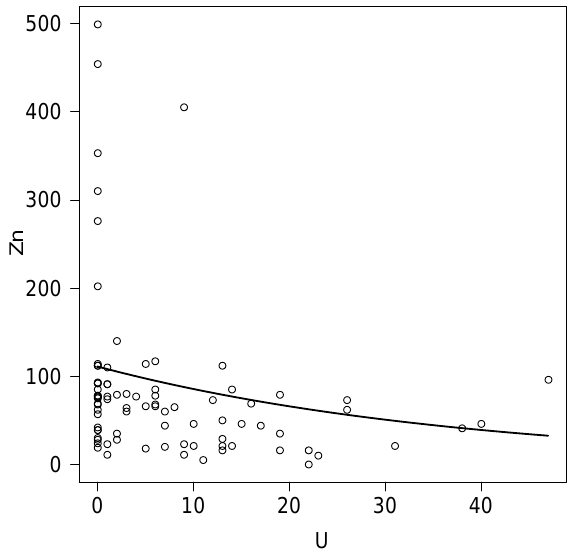
Figure 1. Plots for Zn versus U and the estimated conditional mean for the RLo regression